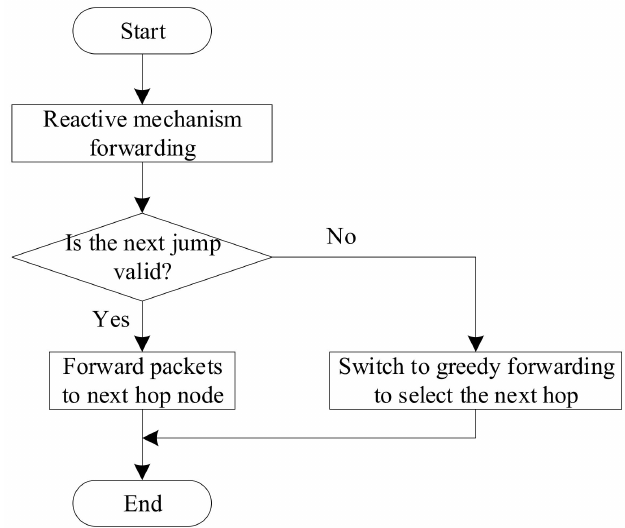
Figure 7. Switching conditions under the reactive mechanism.